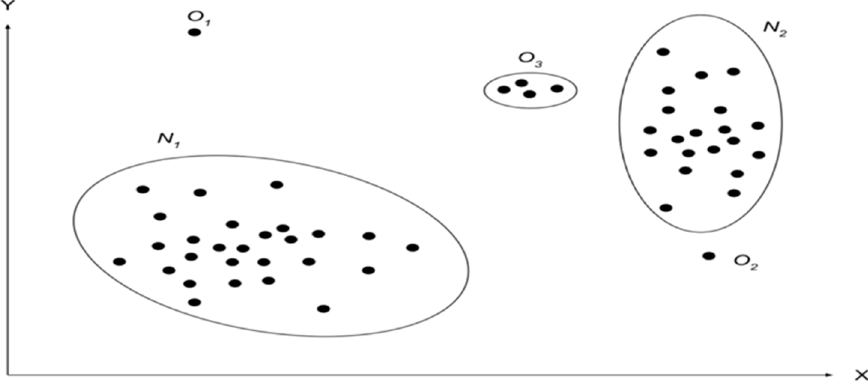
Figure 2 . Point anomaly [6] .